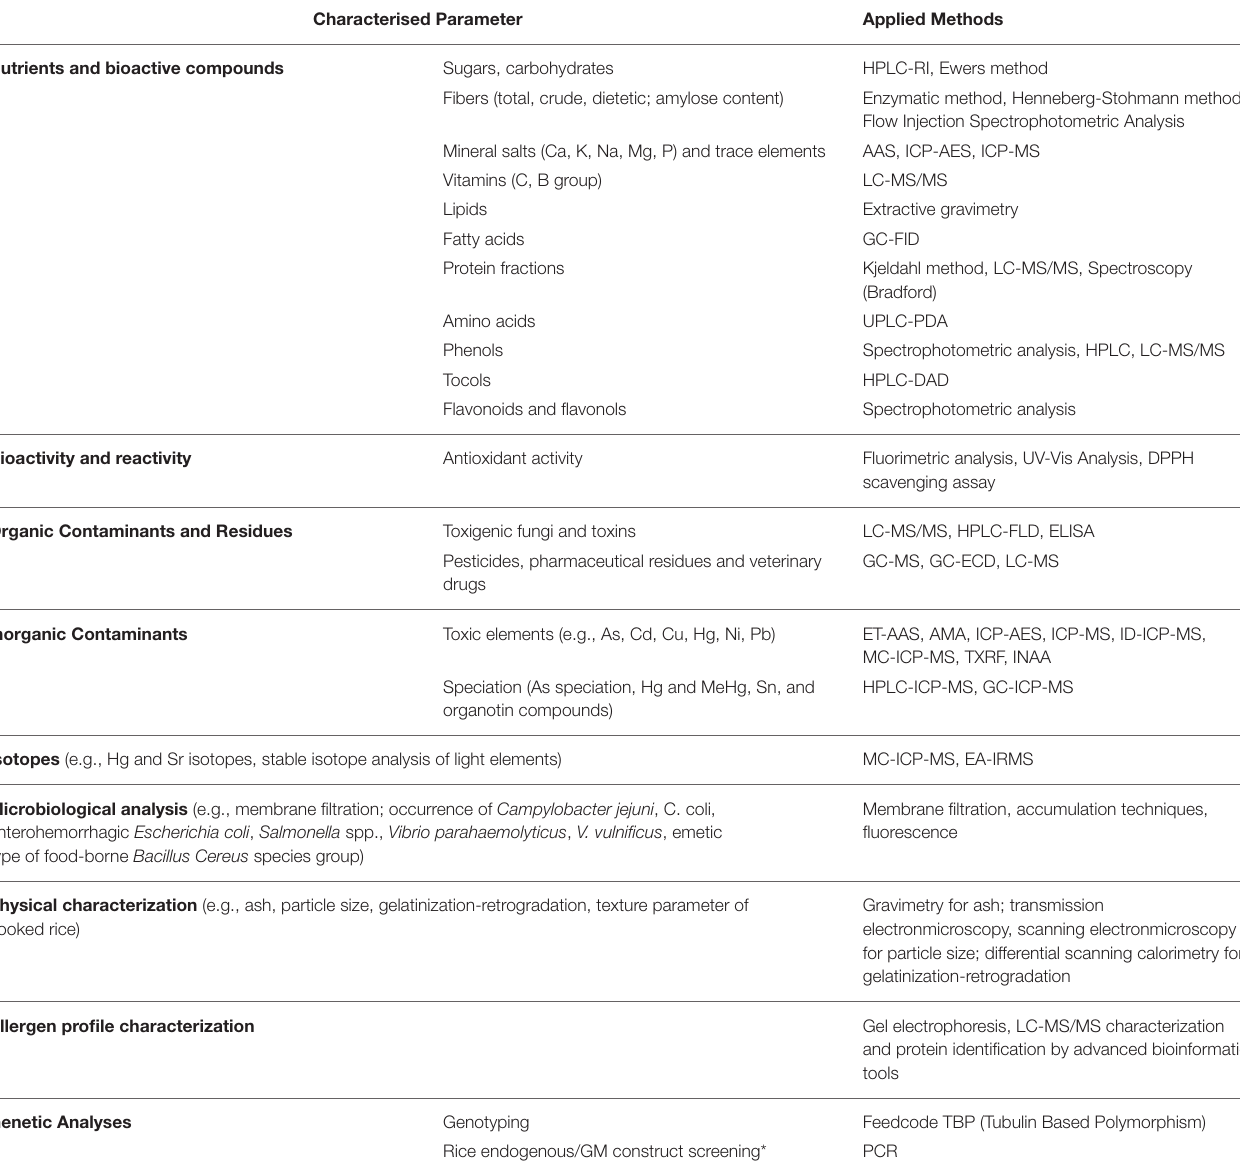
TABLE 1 | Parameters considered for characterization of the reference materials produced during the pilot service implemented in